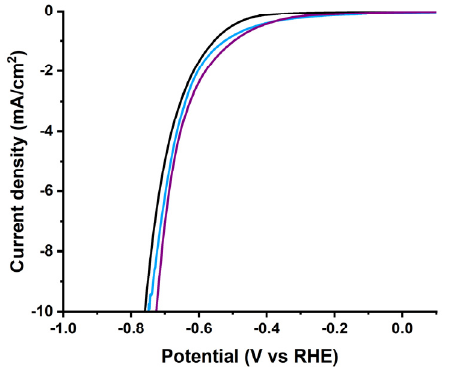
Figure A3. LSV polarization curves for HER of exfoliated graphene (black), pyr-graphene (purple) and imi-graphene (light blue). The LSVs were recorded at 1600 rpm rotation speed and 5 mV/s scan rate in N 2 -saturated aqueous 0.5 M H 2 SO 4 . The current densities are normalized to the geometric electrode area.